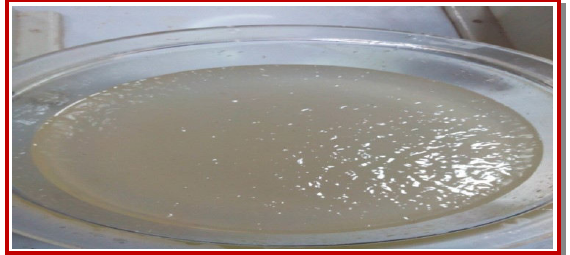
Figure 1: Extracted gel from Plantago ovata